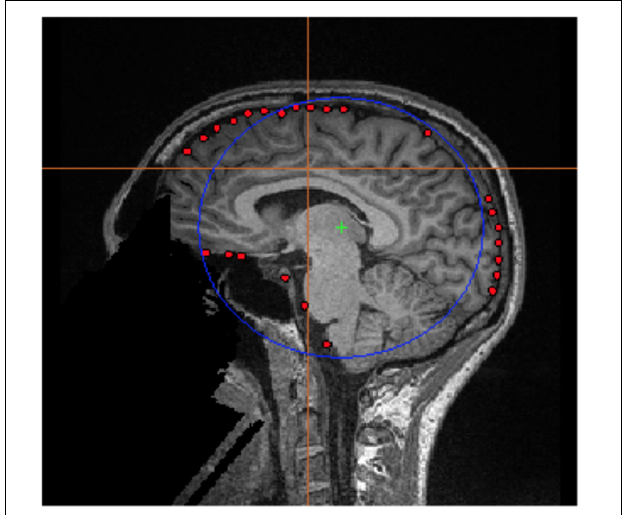
FIGURE 3 | FSL Surface Extraction. Example of the inner skull surface extraction using FSL for subject 001 (red dots), with an overlaid single sphere head model (blue